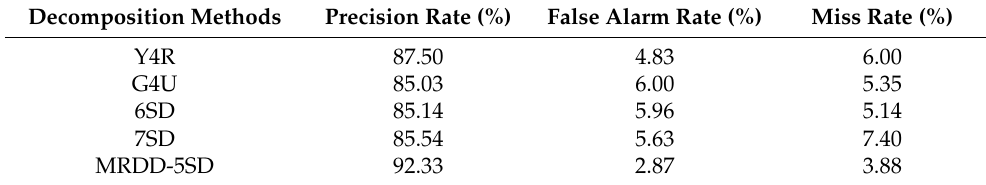
Table 5. Comparison of detection results from different decomposition